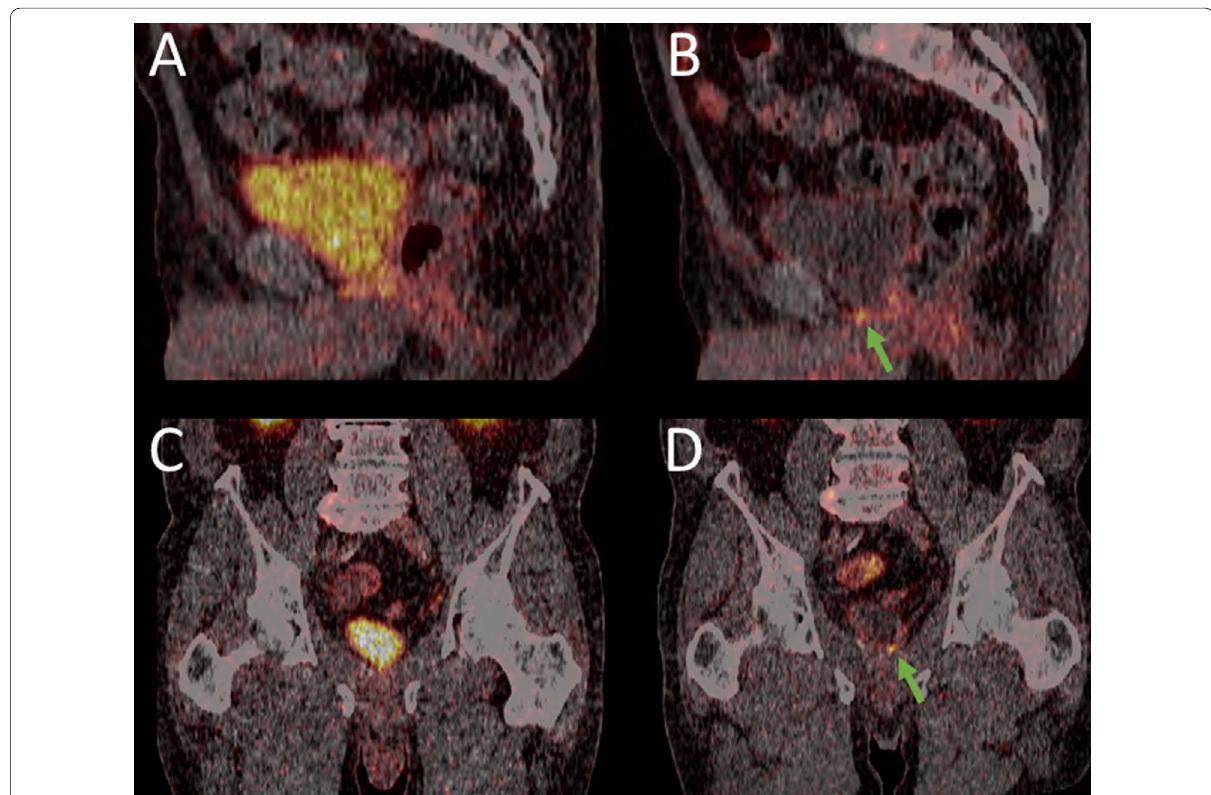
Fig. 4 Sagittal fused [ 68 Ga]-Ga-PSMA-11 ( A ) and [ 18 F]-F-PSMA-1007 PET/CT ( B ) and coronal fused [ 68 Ga]-Ga-PSMA-11 ( C ) and [ 18 F]-F-PSMA-1007 PET/CT ( D ). While in [ 68 Ga]-Ga-PSMA-11, there is only homogenous uptake in the prostatic fossa (A) clear focal uptake indicates local tumor recurrence in [ 18 F]-F-PSMA-1007 PET/CT (green